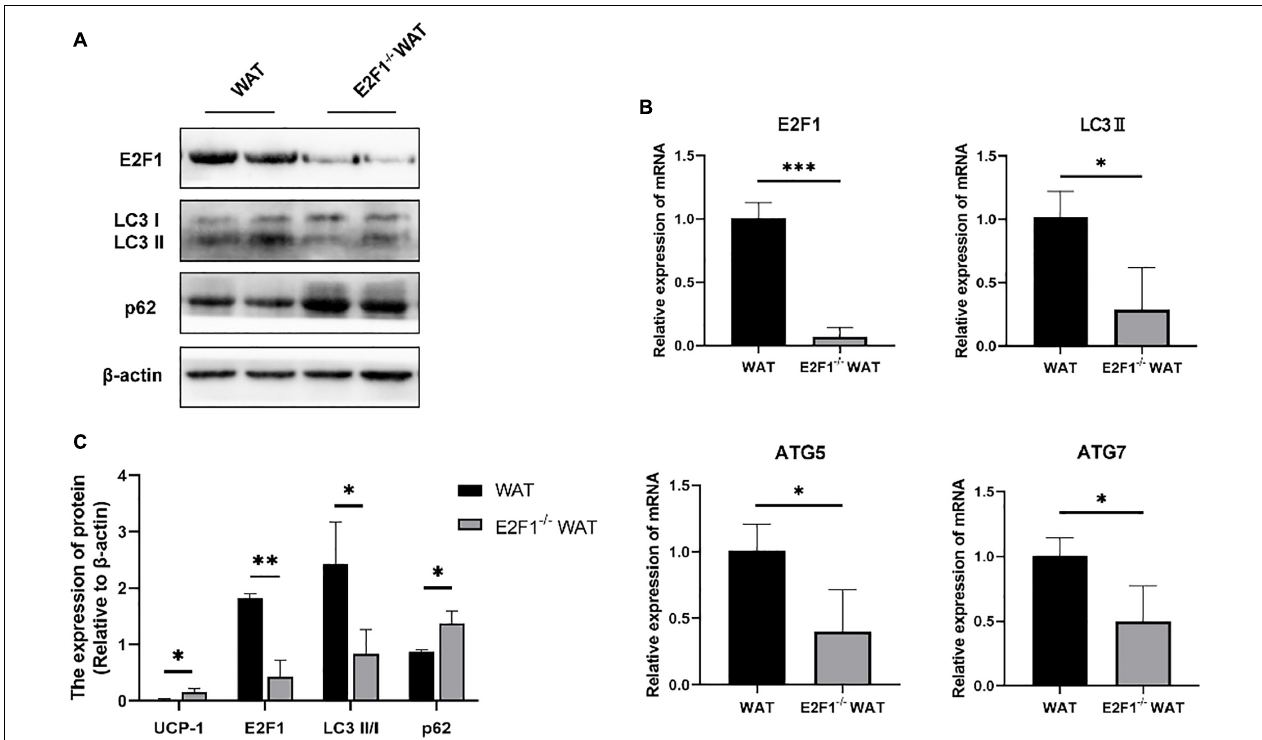
FIGURE 3 | E2F1 knockout affected the expression of autophagy-related proteins in WAT in mice. (A) Representative Western Blot image of E2F1, LC3-II/I, and p62 protein levels in WT and E2F1 − / − WAT. (B) mRNA levels of E2F1, LC3-II, ATG5, and ATG7 genes in WT and E2F1 − / − WAT by qRT-PCR. (C) Quantitative analysis of the protein expressions relative to β -actin, n = 3. ∗ P < 0.05, ∗∗ P < 0.01, ∗∗∗ P <